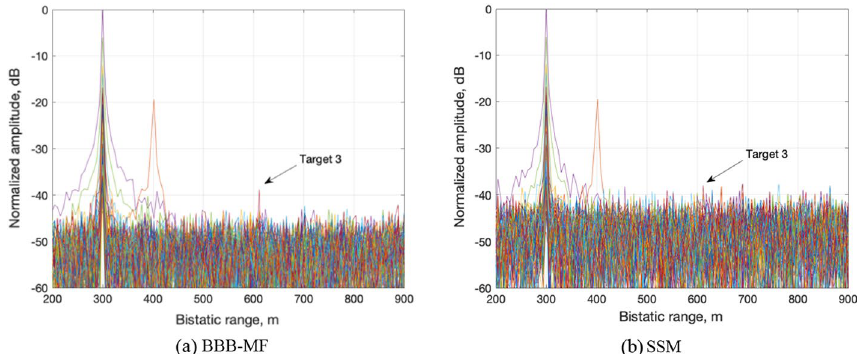
Fig. 6 Range dimension of the processing results by BBB-MF and SSM